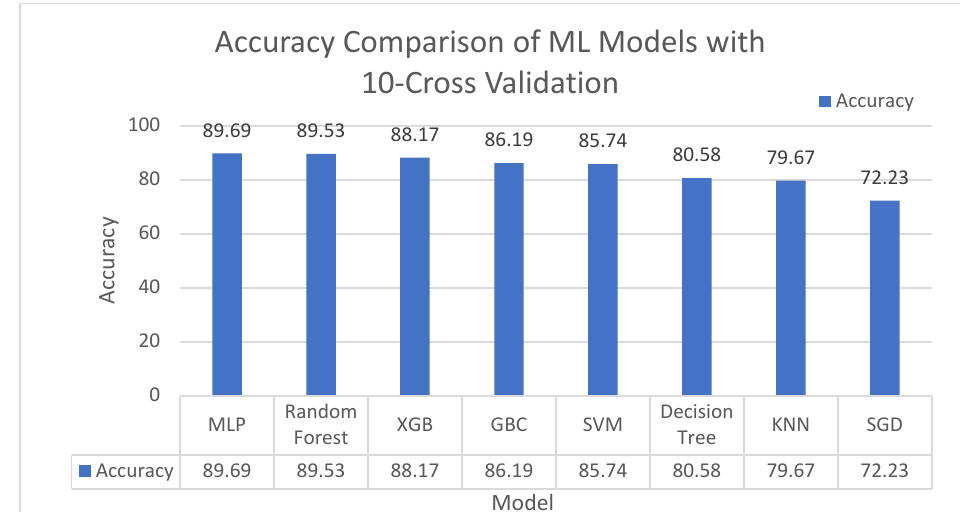
Figure 6. Accuracy Visualization of ML Classifier w.r.t Default Parameters.